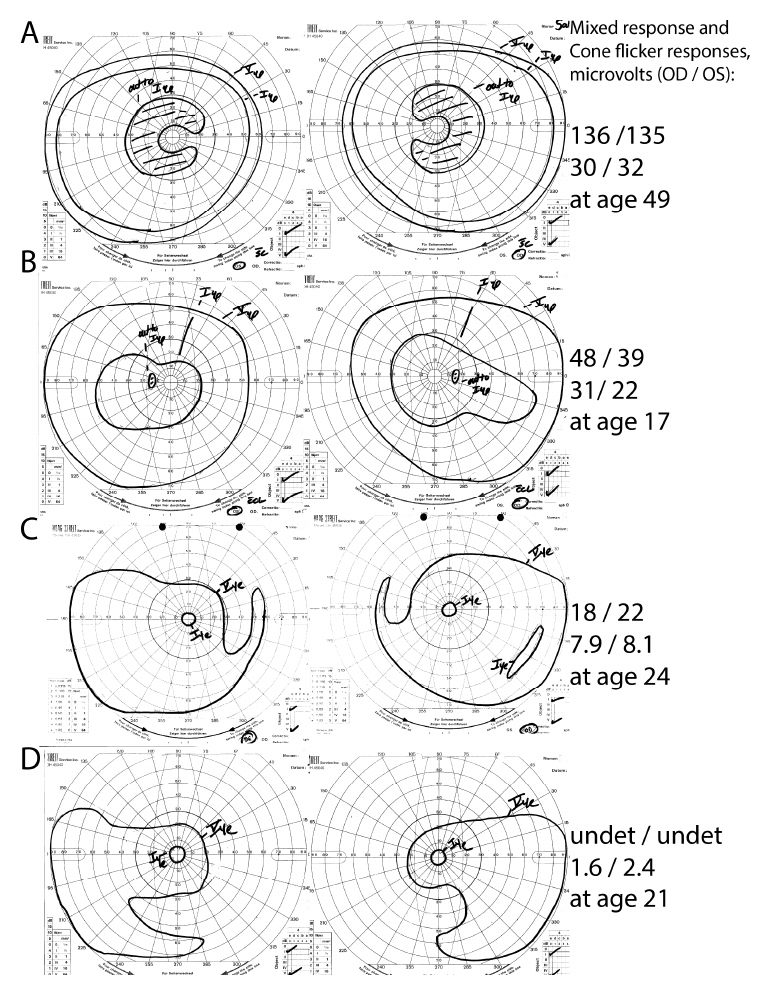
Figure 2. Intra-familial phenotypic variation in family #18. The proband ( A ) had pericentral RP, with near-peripheral C-shaped scotomas with preserved peripheral I4e responses, and relatively preserved full-field ERG responses. His children, in contrast, had either atypically mild RP without pericentral features ( B ) or typical RP ( C , D ). Note the constricted peripheral I4e stimulus responses and lower ERG response amplitudes in the children ( B – D ) in comparison to the proband. undet = undetectable.